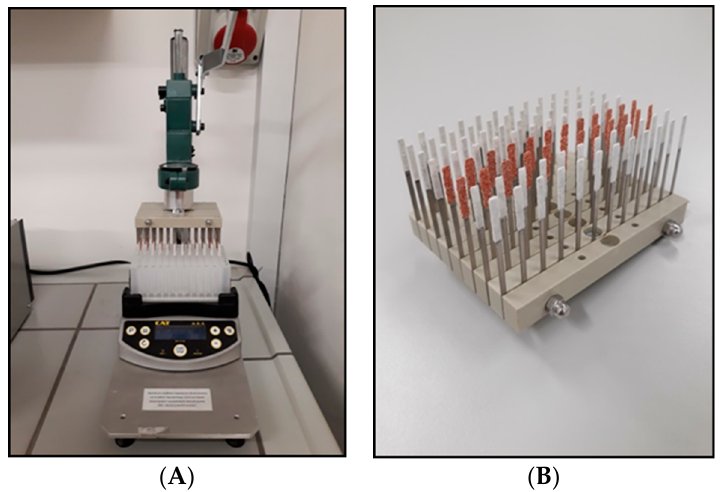
Figure 3. The high throughput 96-semi-automated SPME system used for analysis of urine samples ( A ) and a set of 96 SPME devices coated with different types of extraction phases (the PS-DVB coating selected for the study is represented in rows 3 and 4 from the right) ( B ) .